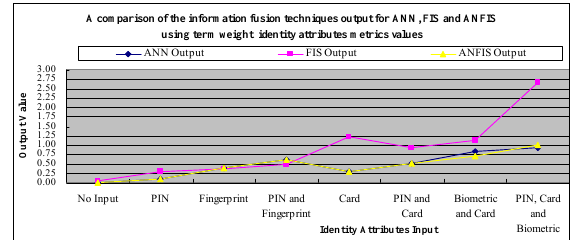
Fig. 6. A comparison of the output values generated by an adaptive neural-fuzzy inference system information fusion technique using term weight and entropy identity attributes metrics